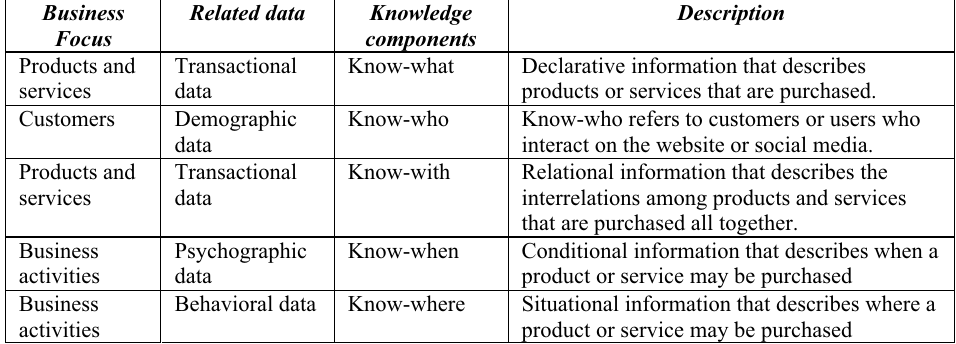
Table 1. Business focusses on the information